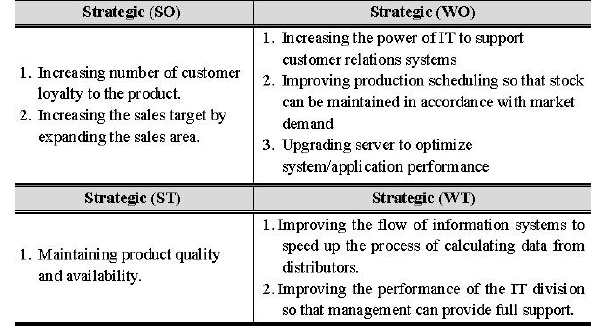
Figure 5: Criteria of Strategic